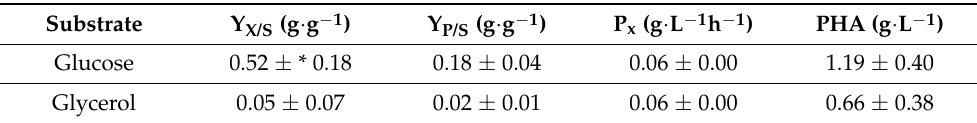
Table 1. Biomass yield per substrate (Y X/S ), product yield per substrate (Y P/S ), volumetric productiv- ity (P x ), and concentration of PHA at 72 h.